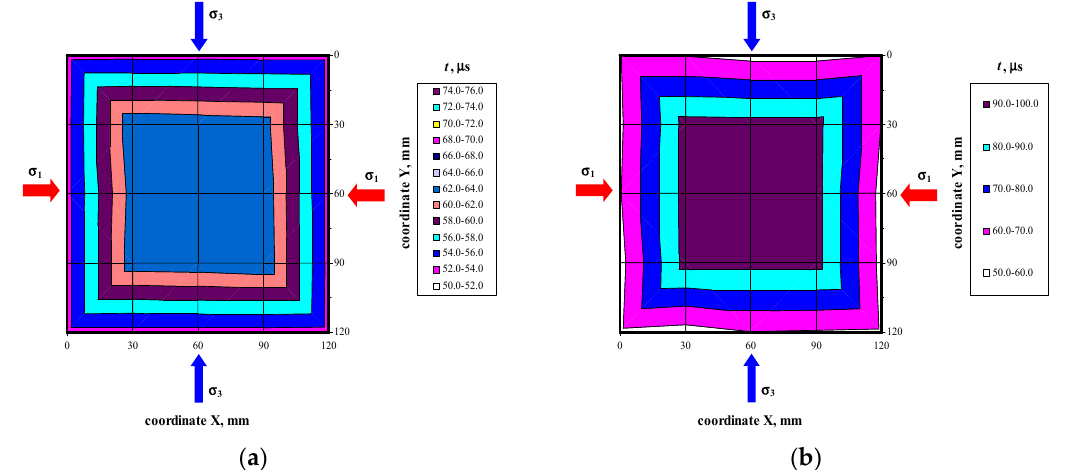
Figure 6. Maps of passing time the ultrasonic wave in the model 400/1 at selected loading levels: ( a ) P = 0, ( b ) P = P max.